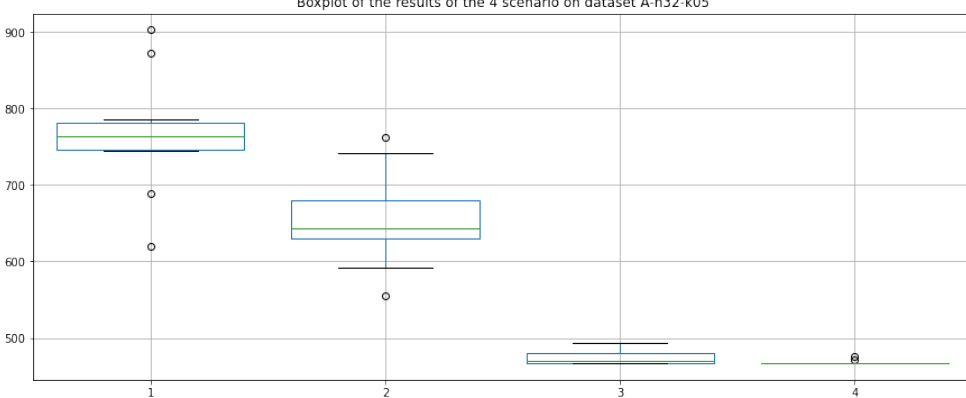
Figure 7. Boxplot of scenarios on the A-n32-k5 task of ABEFMP.